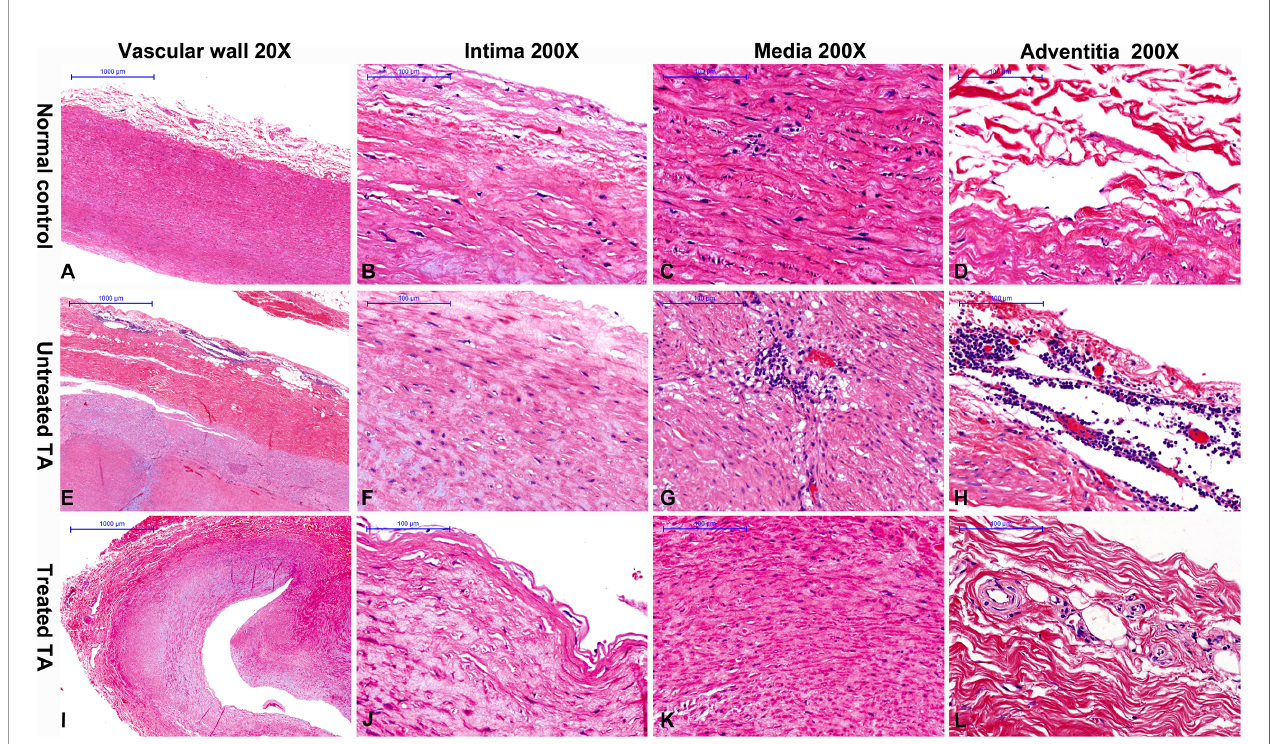
FIGURE 1 | Hematoxylin and eosin staining of vascular tissue from controls, untreated and treated patients with TA (A) Representative hematoxylin and eosin images of normal aorta (A – D) , untreated TA aorta (E – H) and treated TA renal artery (I – L) . A great amount of in fl ammatory cells are observed in untreated patients (H) . The in fl ammatory cells are decreased in treated patients (I)